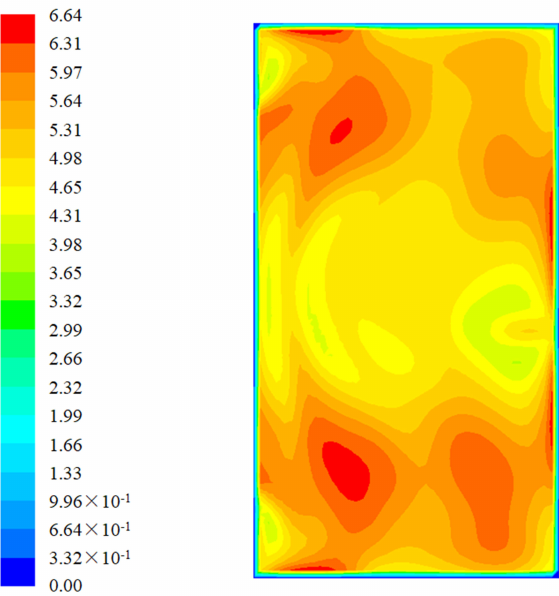
Figure 9. Contours of gas velocity at the observation plane for the optimal design (unit: